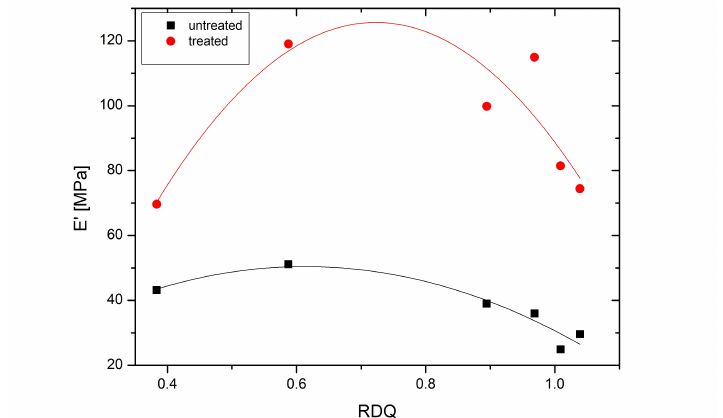
Figure 7. Payne effect of a CNT/NBR nanocomposites before and after the post-treatment.